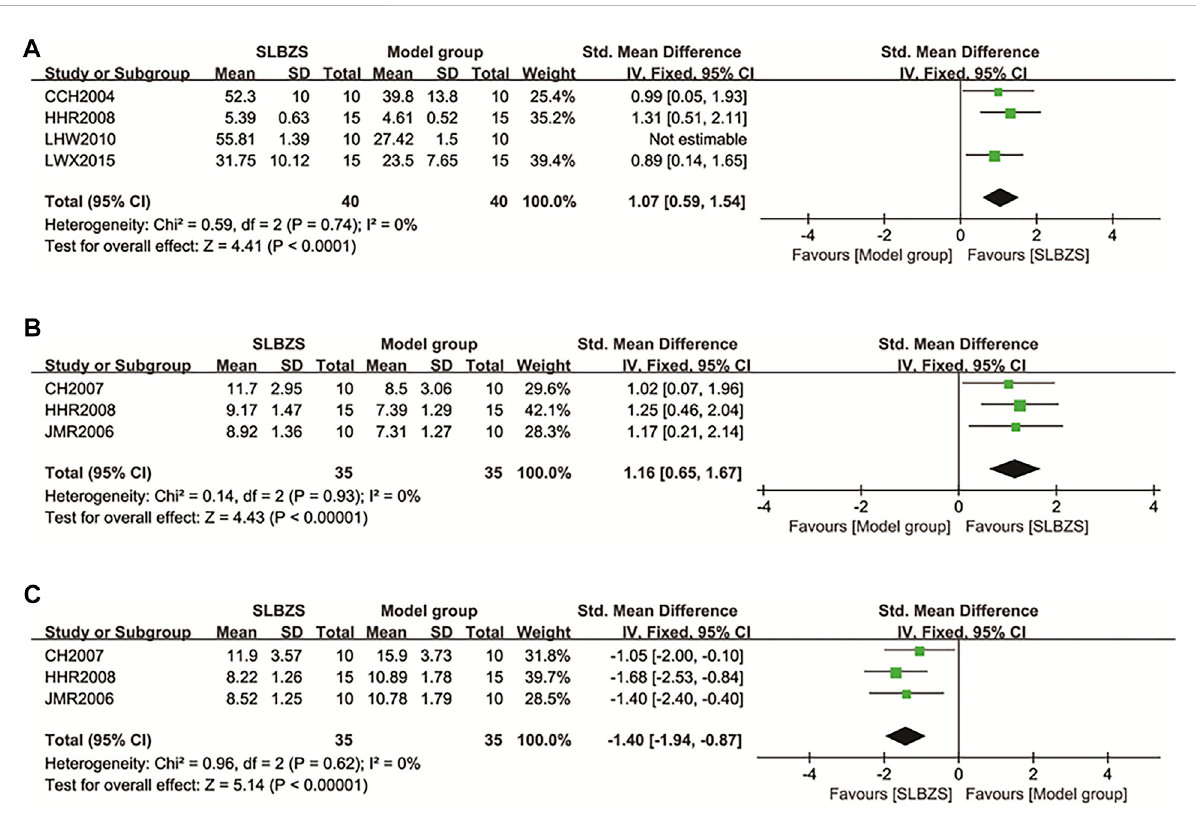
FIGURE 6 (A) The results of macrophage phagocytic capacity. (B) The results of RBC-C3b-RR. (C) The results of